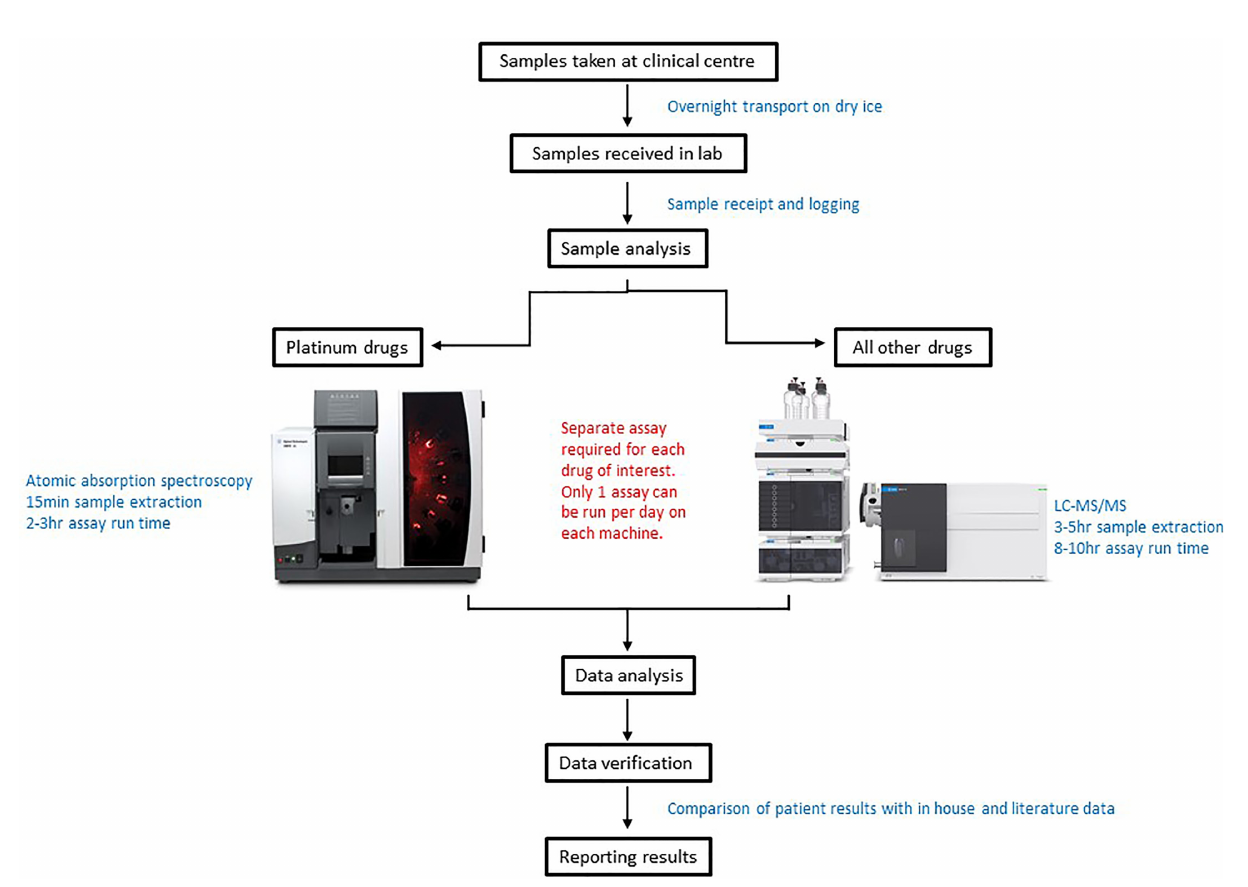
FIGURE 2 | Schematic diagram of the sample analysis processes for patients utilising a Therapeutic Drug monitoring (TDM) approach to